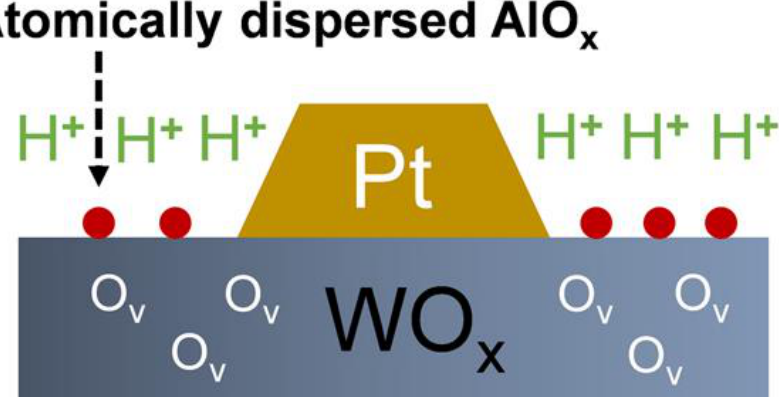
Figure 15. The generation of oxygen vacancies in WO x by the incorporation of atomically dispersed AlO x species. Reproduced from [98] with permission from Elsevier.